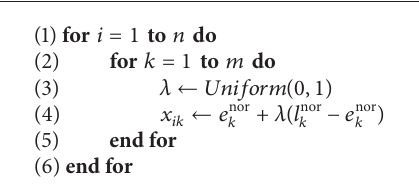
Algorithm 2: Initialization mechanism.